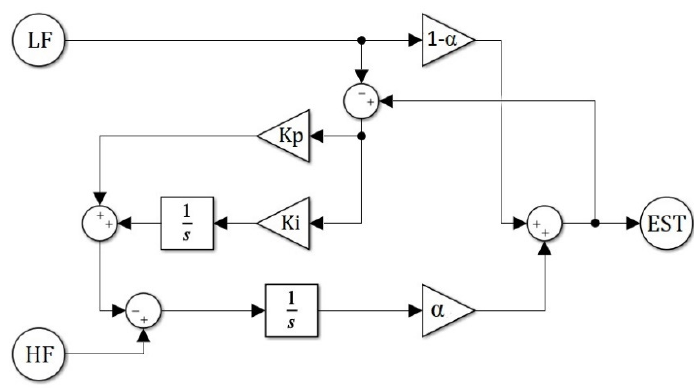
Figure 6. Cascaded complementary filter diagram.